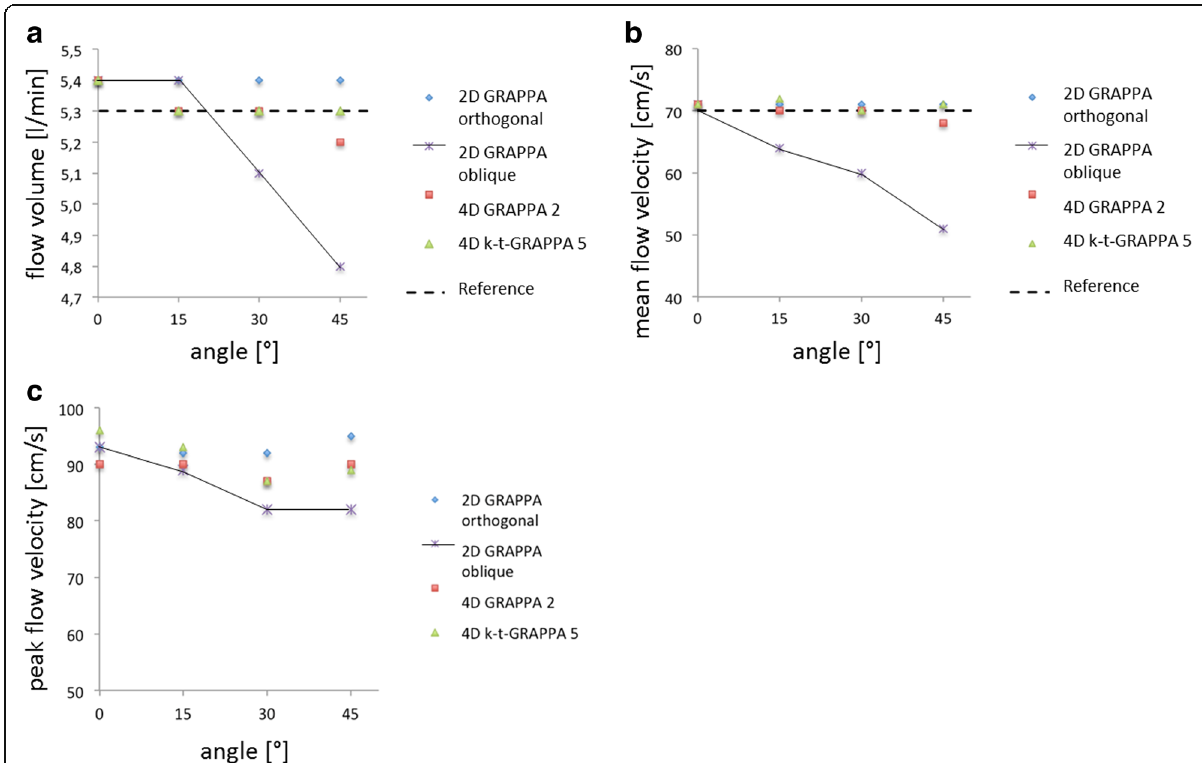
Fig. 4 Influence of misalignment of the measuring plane on 2D flow and 4D flow measurements in constant flow regarding the ( a ) flow volume [L/min], ( b ) mean flow velocity [cm/s], and ( c ) peak flow velocity [cm/s]. 2D, two-dimensional; 4D, four-dimensional; cm/s, centimetres per second; GRAPPA, generalised autocalibrating partially parallel